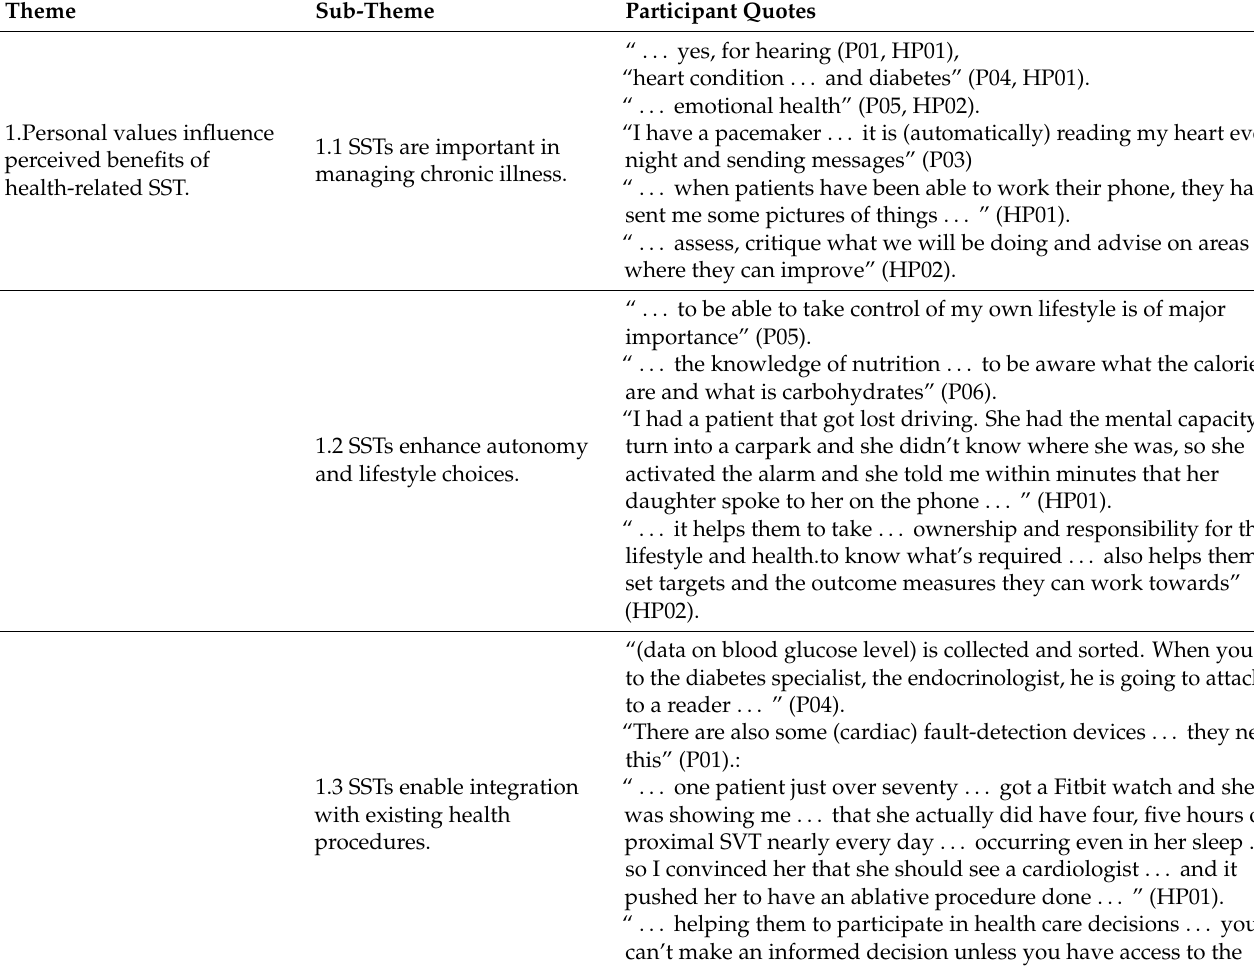
Table 2. Research Question 3